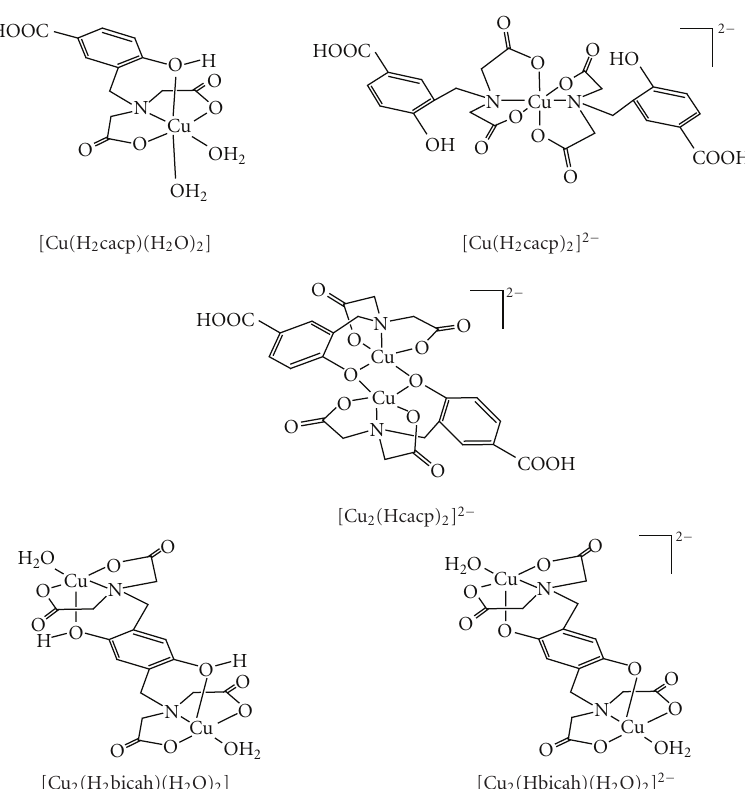
Scheme 2: Molecular drawings of the structures of the phenol and p -hydroquinone iminodiacetate copper(II) complexes, isolated at a pH range 2.0–9.0 according to a recent detailed crystallographic study